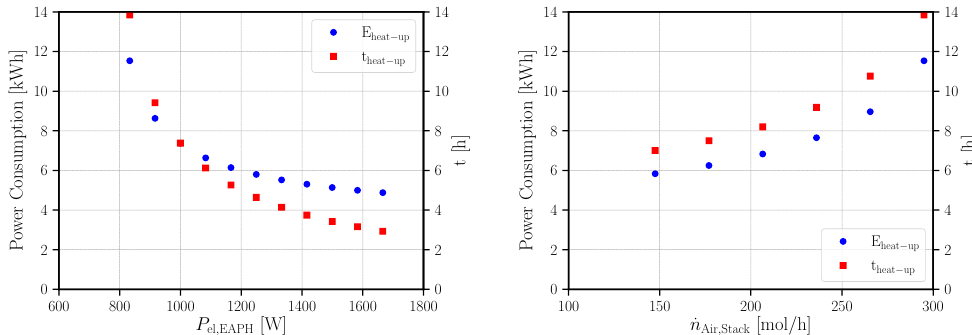
Figure 16. Variation of the power input at the electrical heater EAPH ( left ) and of the cathode air input ( right ) with its effects regarding the heat-up time and the resulting power consumption, assuming a stack target temperature of 670